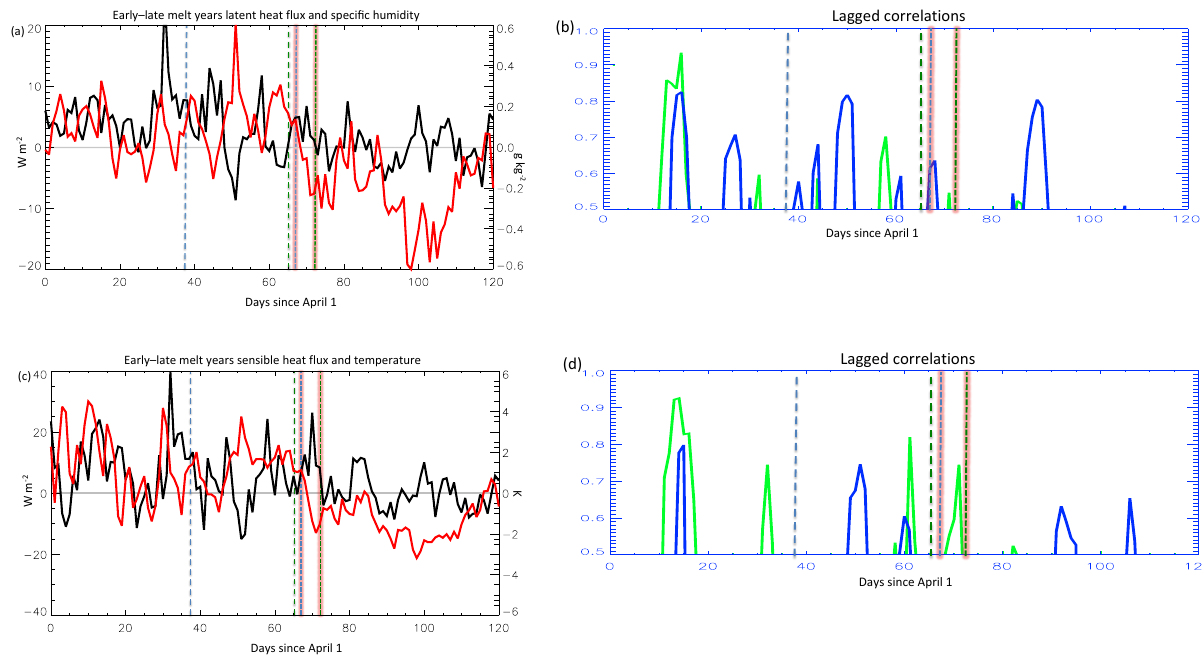
Figure 9. (a) Baffin Bay SIC region latent heat flux from early minus late MO years (black line) and Baffin Bay GrIS region specific humidity from early minus late MO years (red line). Dotted vertical lines represent the average early melt onset date for Baffin Bay (dotted blue), average late melt onset date for Baffin Bay (dotted blue, red highlight), average early melt onset date for GrIS (dotted green), and average late melt onset date for GrIS (dotted green, orange highlight). (b) One-week lagged running correlations (between 0.5 and 1.0) for early melt years latent heat flux from Baffin Bay and specific humidity from GrIS (blue) and late melt onset latent heat flux from Baffin Bay and specific humidity from GrIS years (green). (c) Baffin Bay SIC region sensible heat flux from early minus late MO years (black line) and Baffin Bay GrIS region air temperature from early minus late MO years (red line). Dotted vertical lines represent the average early melt onset date for Baffin Bay (dotted blue), average late melt onset date for Baffin Bay (dotted green), average early melt onset date for GrIS (dotted blue, red highlight), and average late melt onset date for GrIS (dotted green, orange highlight). (d) One-week lagged running correlations (between 0.5 and 1.0) for early years sensible heat flux from Baffin Bay and air temperature from GrIS (blue) and late melt onset sensible heat flux from Baffin Bay and air temperature from GrIS years (green). Table 3. Percentage of grid cells with a significant correlation at α = 0 . 05 relative to the total grid cells of the unmasked ice sheet. The Pearson’s correlation is between ice sheet meltwater production and area-averaged sea ice concentration anomalies in the Beaufort Sea and Baffin Bay (hatched regions in Figs. 5a and 6a, respectively). Month Beaufort Sea Baffin Bay Simple Partial Simple Partial correlation (%) correlation (%) correlation (%) correlation (%) June 87.0 81.0 July August 32.6